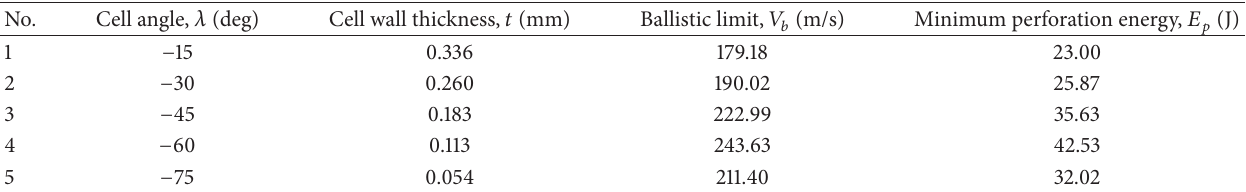
Table 4: Specifications and numerical results of a group of auxetic HSPs with identical mass ( 𝑇 𝑓 = 1.0 mm, 𝑇 𝑐 = 50mm, and 𝜌 = 0.15) and unit cell wall lengths ( ℎ = 8mm and 𝑙 = 4mm), but different cell angles and wall thicknesses, so that the effects of cell angle and wall thickness can be studied.